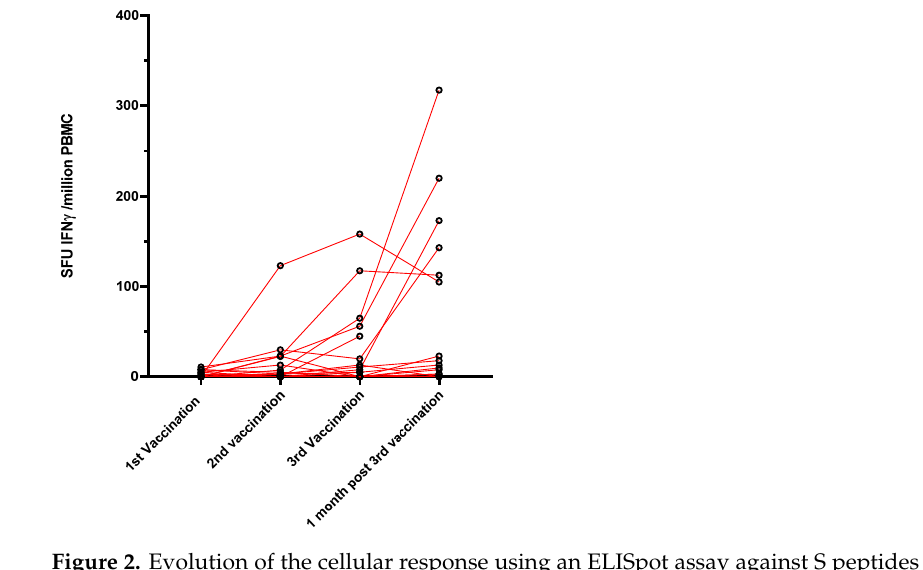
Figure 2. Evolution of the cellular response using an ELISpot assay against S peptides (SFU: spot- forming unit).